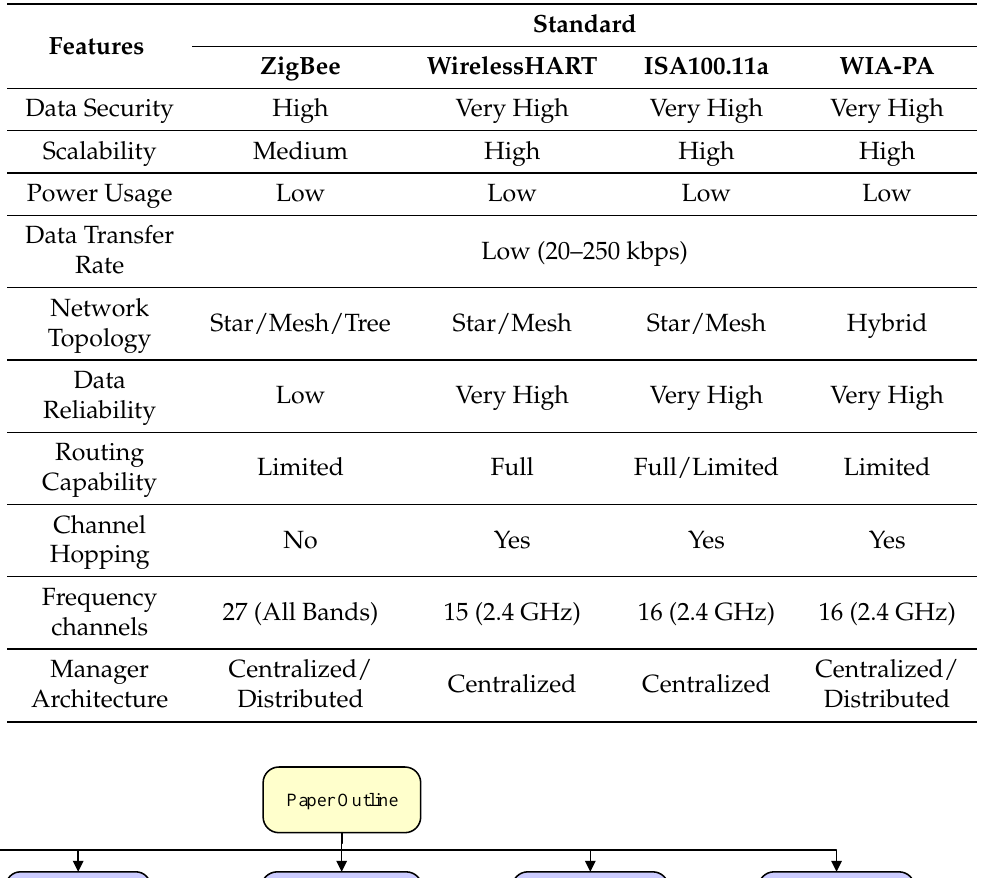
Table 2. Features comparison between the different industrial wireless sensor networks [14].